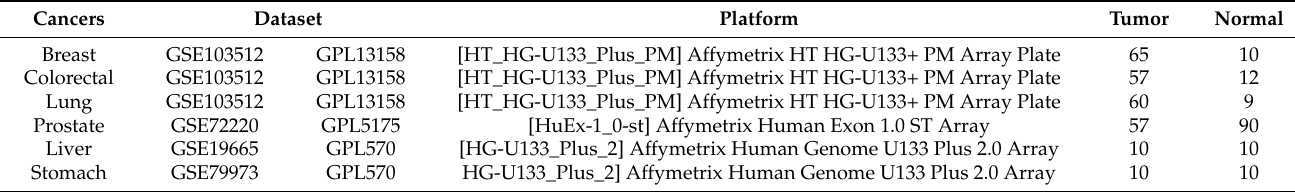
Table 2. Distribution of data collection from the NCI Genomic Data Commons.